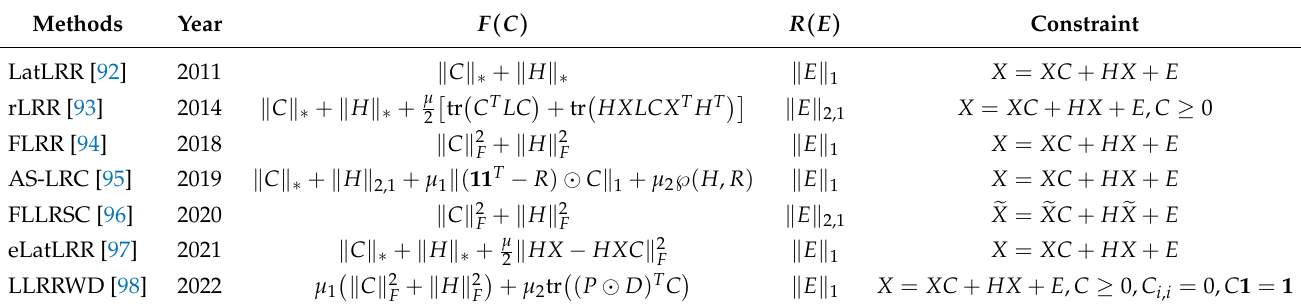
Table 6. The comparison of classical latent representation SC